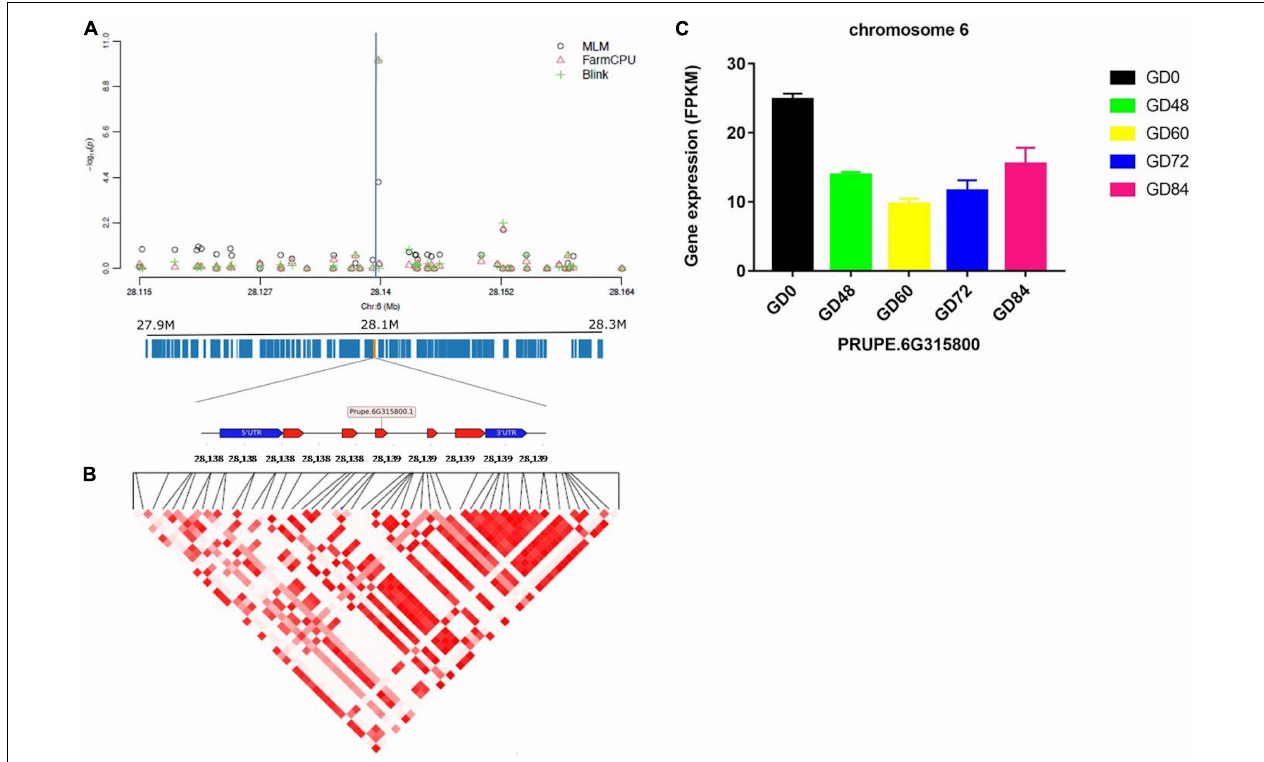
FIGURE 6 | Significant associations and candidate genes on Chromosome 6, underlying peach gummosis disease. (A) Manhattan plots showing the significance of SNP rs285957 at the chromosome-wide level. The vertical blue lines indicate the position of the significant locus identified by three different models. The annotated candidate genes and the gene structure are represented below the plot. (B) Pairwise correlation of LD ( r 2 ) between significant SNPs along the highlighted genomic region. (C) Relative expression of Prupe.6G315800 obtained by comparative RNA-Seq profile during the inoculation of